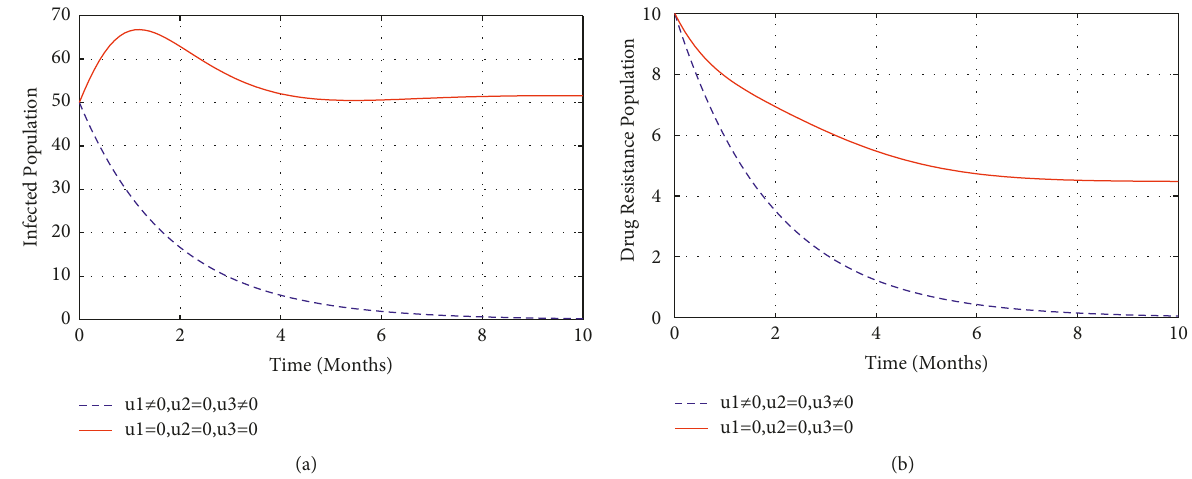
Figure 6: Impact of education and treatment of drug resistance population on infectious and drug resistance